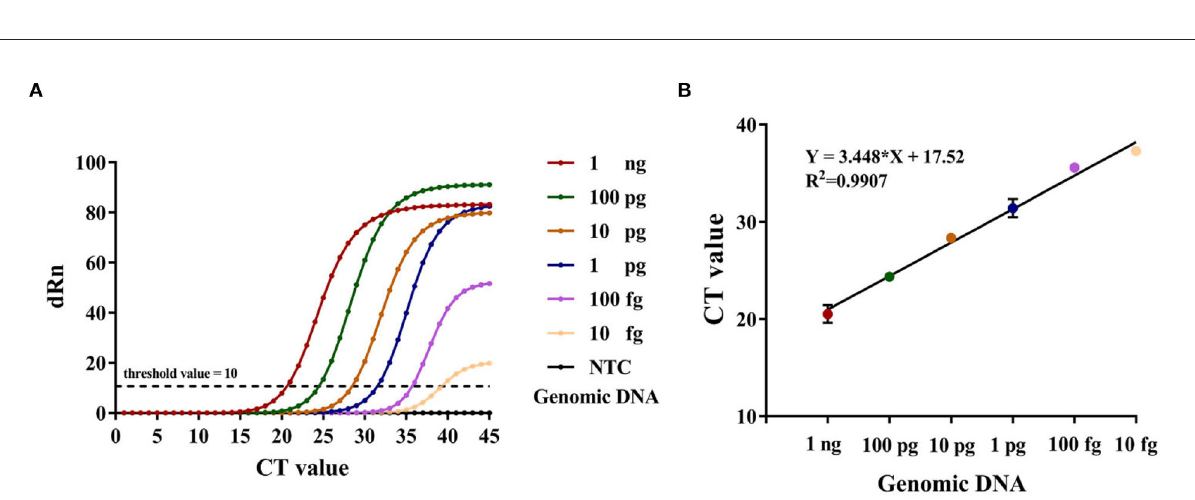
FIGURE5 (A) The amplification curve of RT-PCR, Y-axis: dRn = Rn (sample) - Rn (Blank), Rn = R/RROX. (B) Standard curve developed using 10-fold serial dilution of DNA from F. tularensis ranging from 1 ng to 10 fg of genomic DNA. Error bars represent mean ± SEM, where n = 2